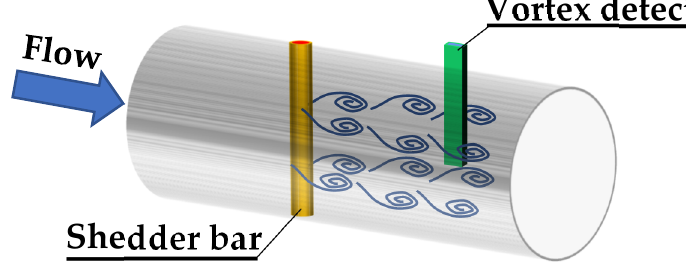
Figure 1. Vortex flowmeter.